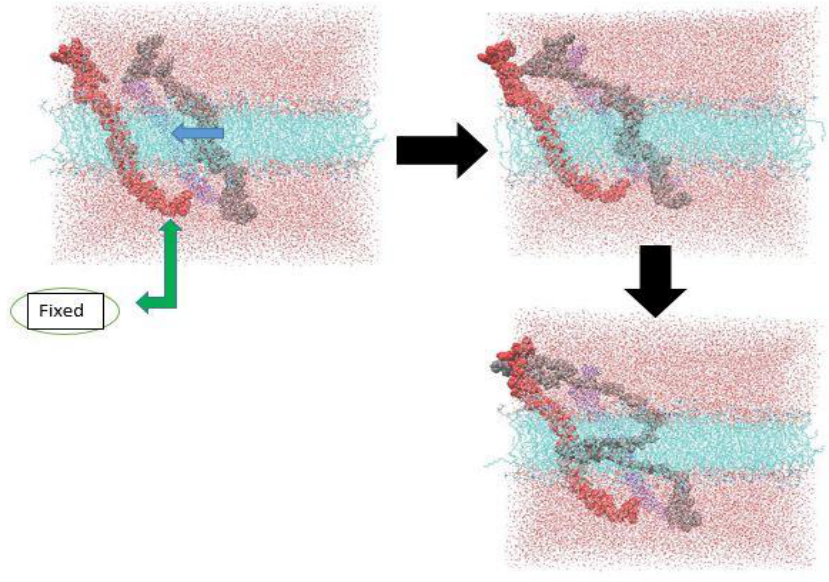
Figure 11. β-subunit all-atom SMD simulation, when one is